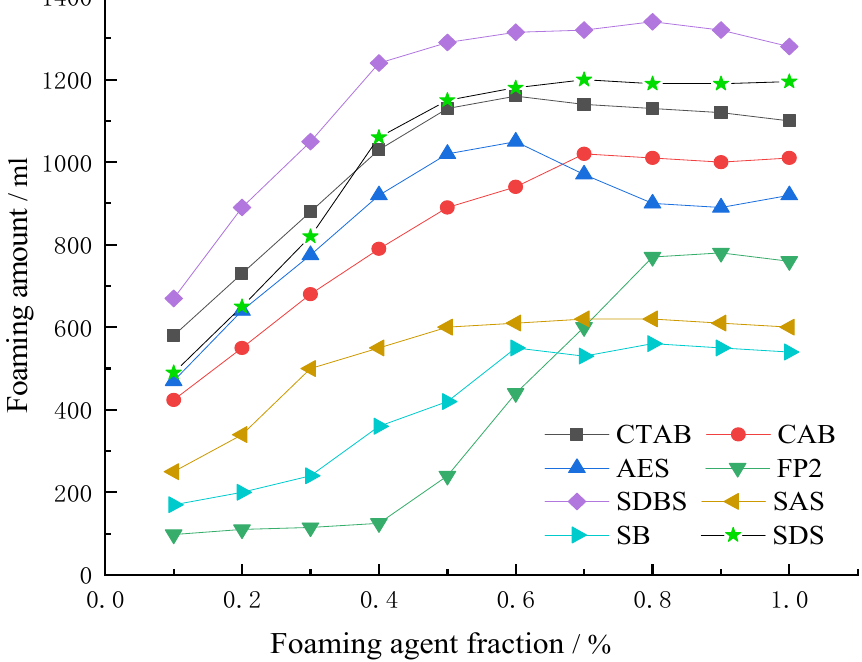
Figure 4. Foaming multiples of a single foaming agent.